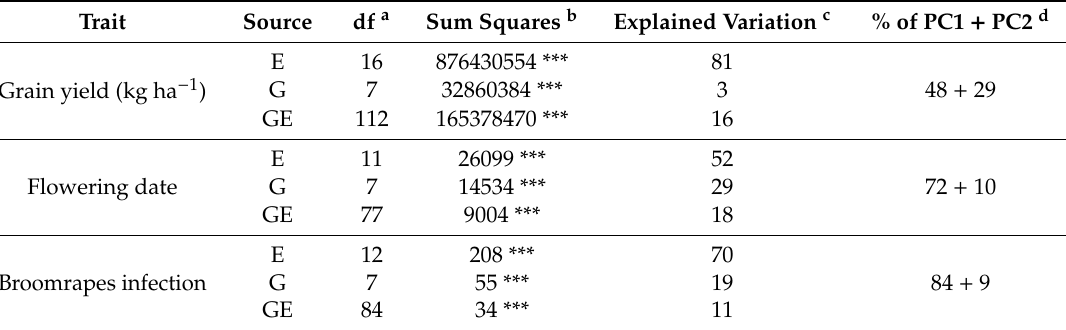
Table 2. Genotype (G), field–year environment (E) and genotype by field–year environment interaction (GE) terms for grain yield, days to flowering and number of broomrapes per plant of eight genotypes of L. sativus .